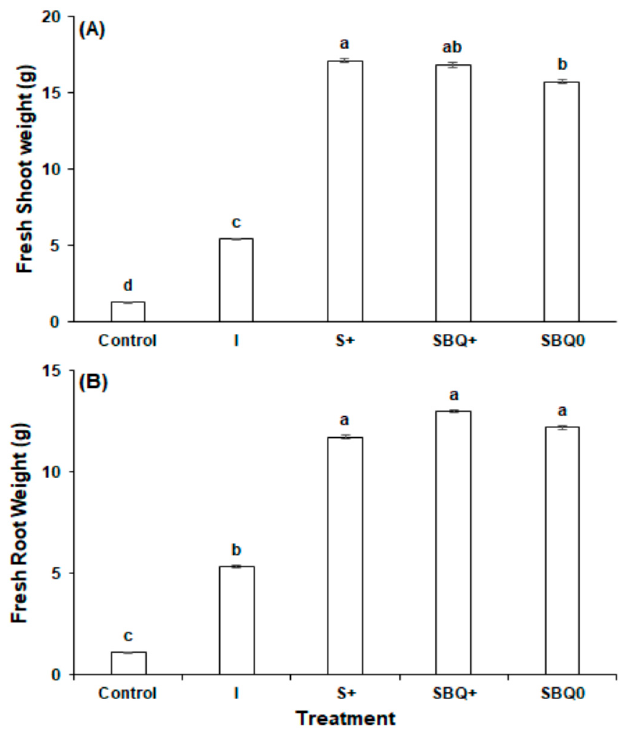
Figure 3. Fresh weight of radish in experiment 2: ( A ) Shoot weight ( B ) root weight. All different letters are significant at p <